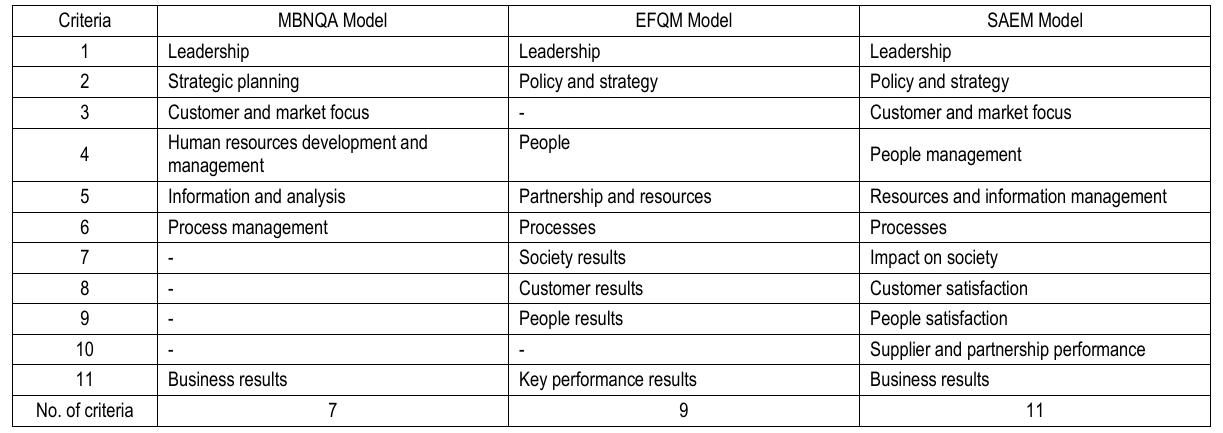
Table 2. Comparison of Criteria for the Excellence